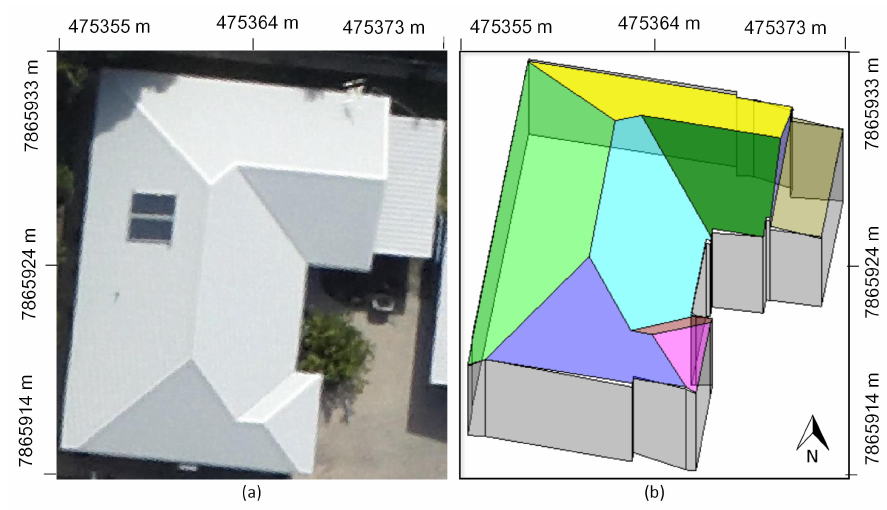
Figure 7. Complete building model for the sample building: ( a ) aerial image; and ( b ) 3-D model.